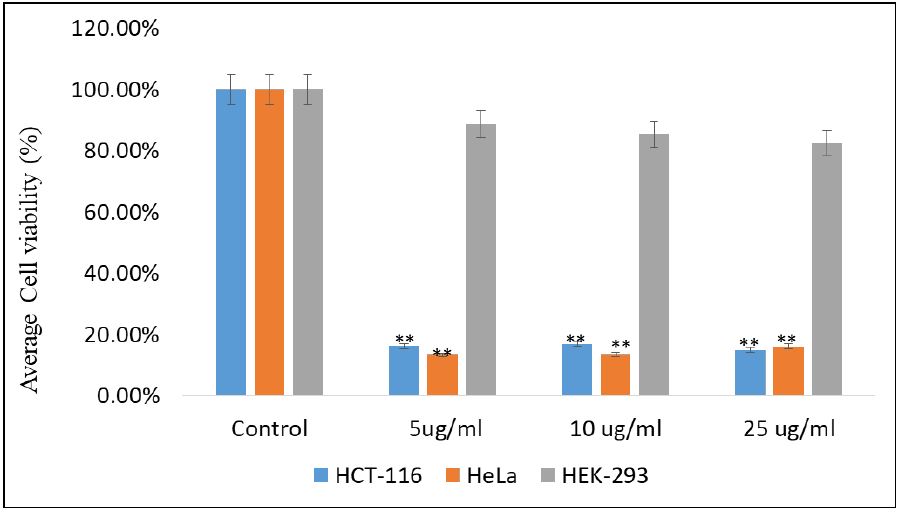
Figure 17. Effects of chrysophanol on HeLa, HCT-116 and HEK-293 cells cell viability assessed by MTT assay. ** p < 0.01.